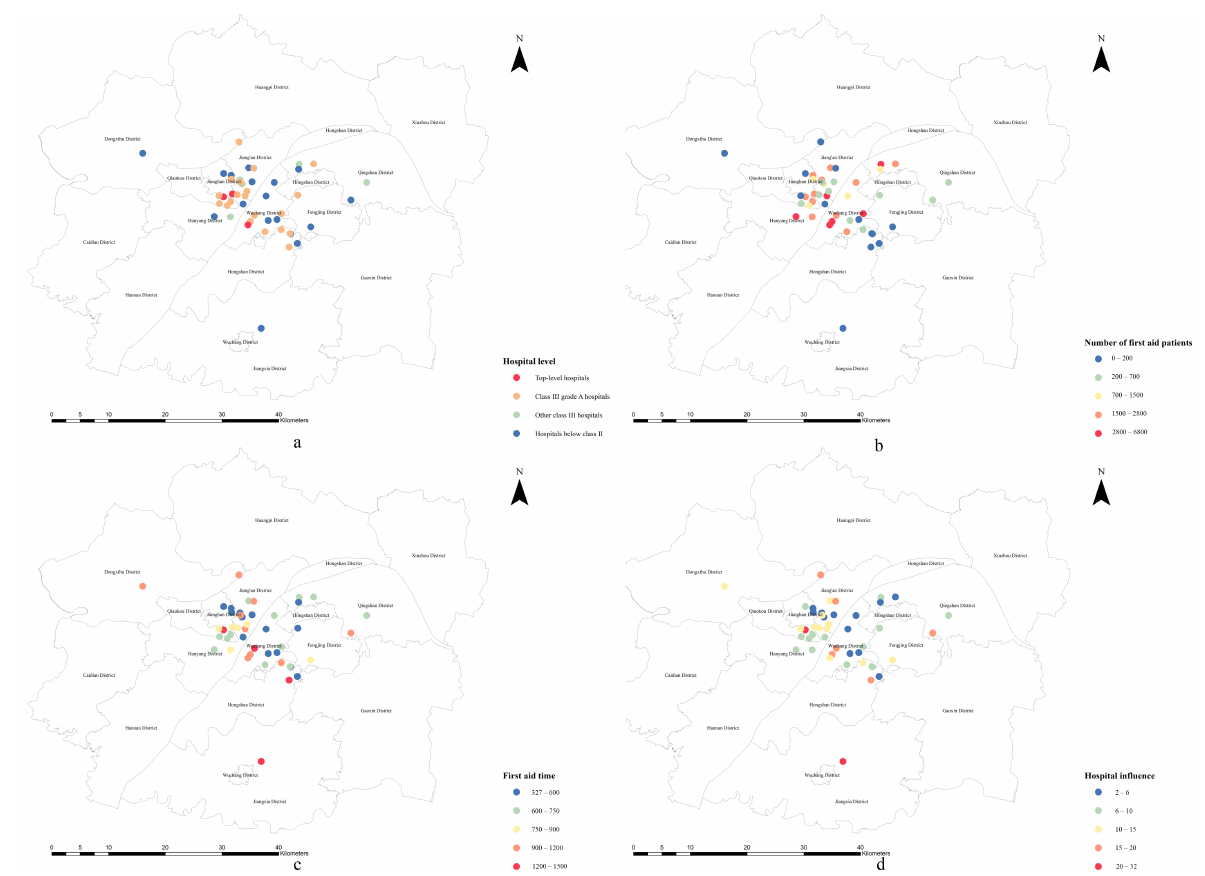
Figure 4. The spatial characteristics of the analyzed hospitals: hospital level ( a ), number of first aid patients ( b ), time to first aid treatment ( c ), and hospital influence ( d